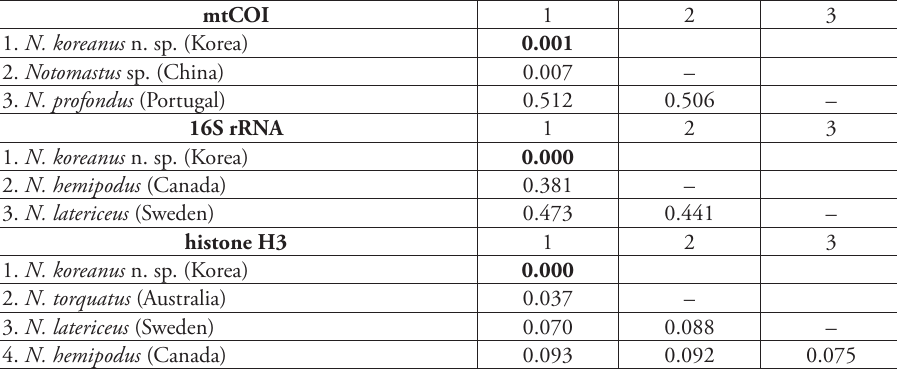
Table 3. Mean genetic distances between examined Notomastus species based on K2P distance. Bold numbers represent the mean intraspecific K2P distance of Korean